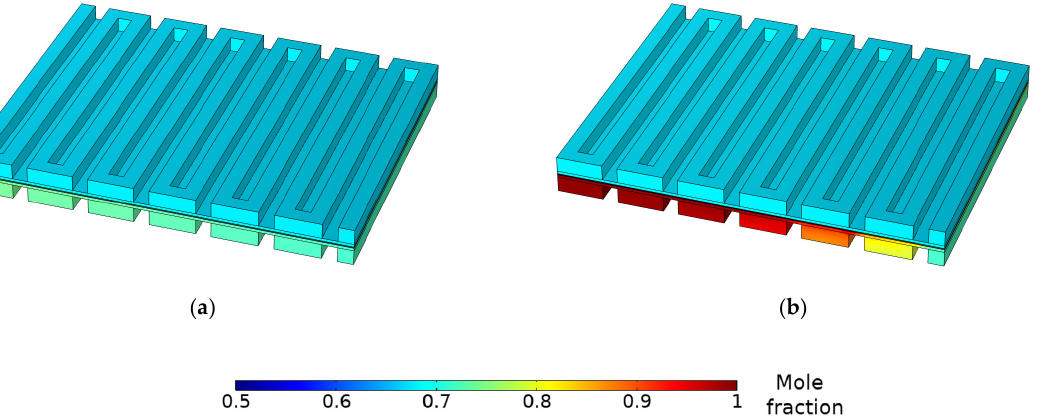
Figure 8. Water mole fraction distribution in both anode and cathode sides for cell voltage of ( a ) 0.75 V and ( b ) 0.25 V.